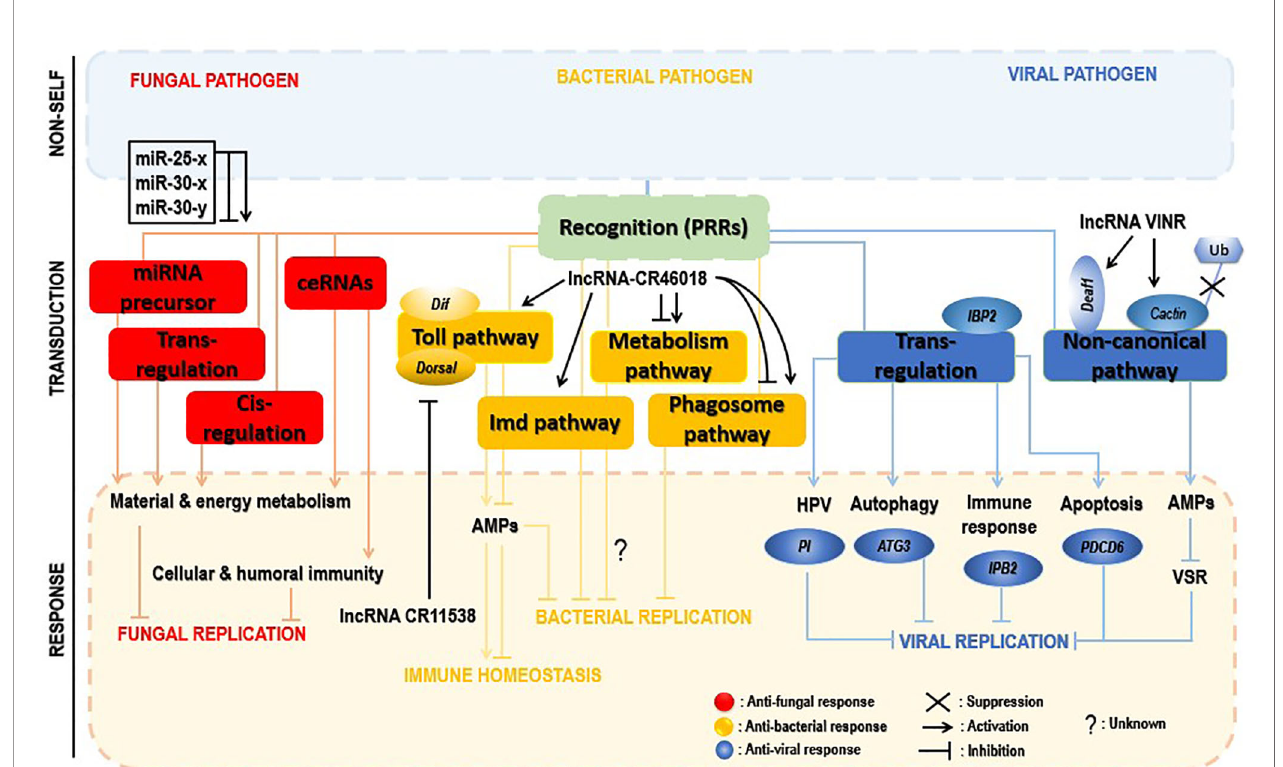
FIGURE 5 | Insect immune defense modulation by lncRNAs upon microbial attacks. The fungal invasion of insects induced alteration of a myriad of insect lncRNAs, which regulate neighboring genes in cis and trans or act by interacting with miRNAs (sponges) or being miRNA precursors. Those trans -and cis-acting predominantly activate material and energy metabolism processes and cellular and humoral immunity, hence helping in control of the infection (red). lncRNAs inhibit bacterial replication via positive regulation of the Toll pathway, the phagosome pathway, or the metabolism process. However, the latter signaling pathway required more investigation to understand how its deactivation contributes to decreased pathogen replication. Additionally, to avoid immune overactivation after bacterial invasion, insect lncRNAs decoy the critical components of the Toll pathway, lowering the expression of AMPs, thus promoting host immune response homeostasis (yellow). During the viral invasion of insects, insect lncRNAs positively trans -regulate insect genes (PI, ATG3, IBP2, PDC6, etc.) involved in cellular and humoral immune- related pathways (HPV, autophagy, apoptosis, etc.). Viral suppression is also achieved through activation of a noncanonical pathway, as an alternative to compensate the RNAi pathway failure; deployed lncRNAs inhibit both the virulence suppressor of RNAi (VSR) and the ubiquitination of cactin in the nucleus or indirectly target the transcription factor Deaf1 and the RNA polymerase II (RNAPII) for transcription of AMPs to control the viral replication